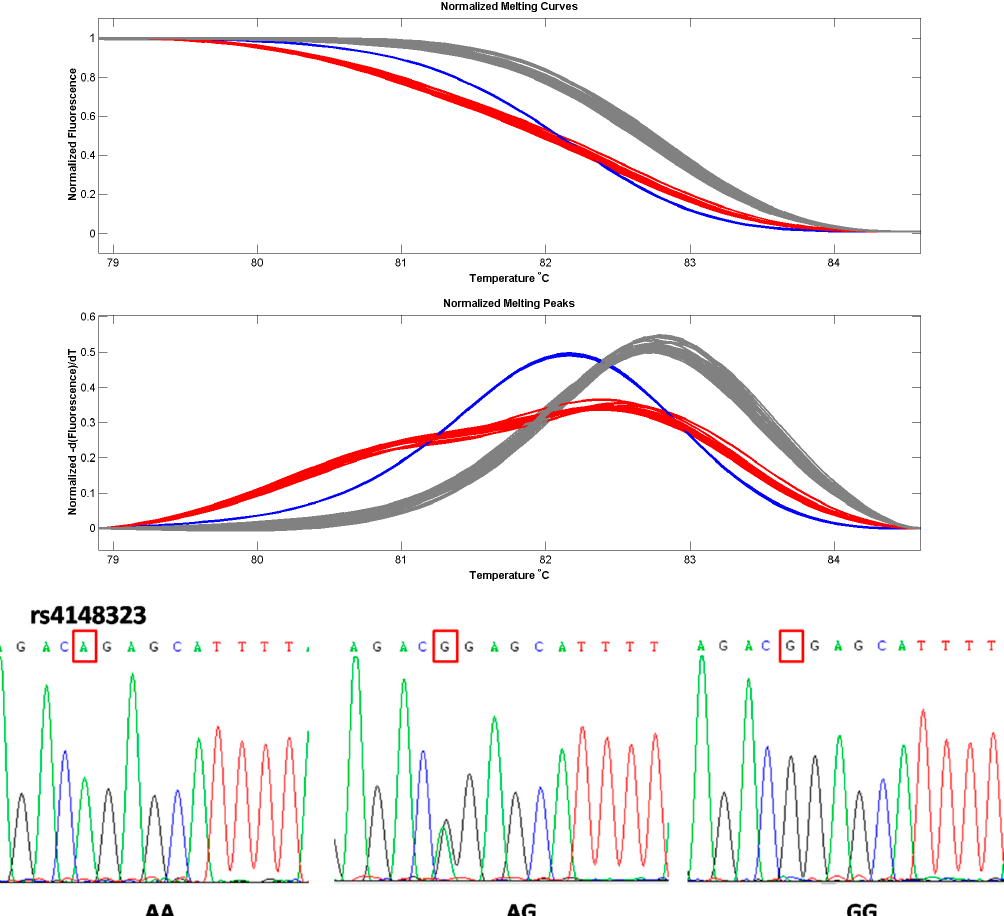
Figure 1. Genotyping and sequencing of rs4148323. Melting curves and genotyping results showed AA genotypes (blue curves), AG heterozygous types (red curves) and GG genotypes (gray curves). Sequencing results confirmed homozygotes (AA), heterozygotes (AG) and homozygotes (GG). Table 2. The genotype frequencies of rs4148323 in laryngeal cancer patients and controls. Patients ( n = 103) Controls ( n = 220) Genotype OR (95% CI) a p Number (%) Number (%)